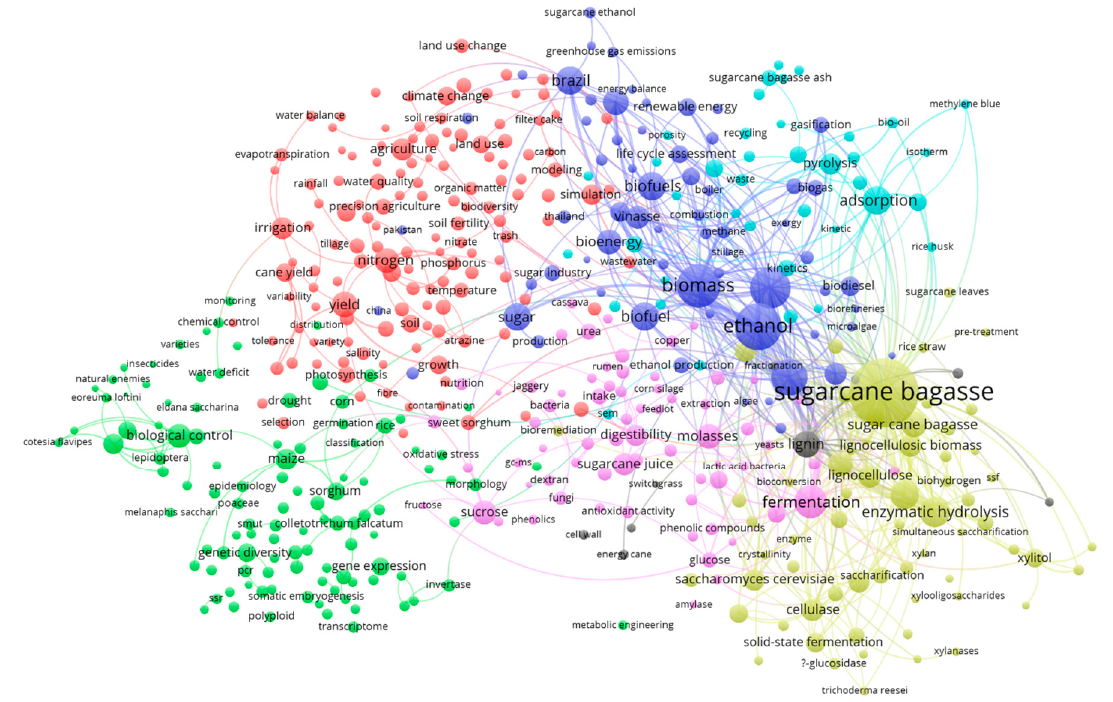
Figure 5. Network showing the co-occurrence of terms in sugarcane research with five co- occurrences.